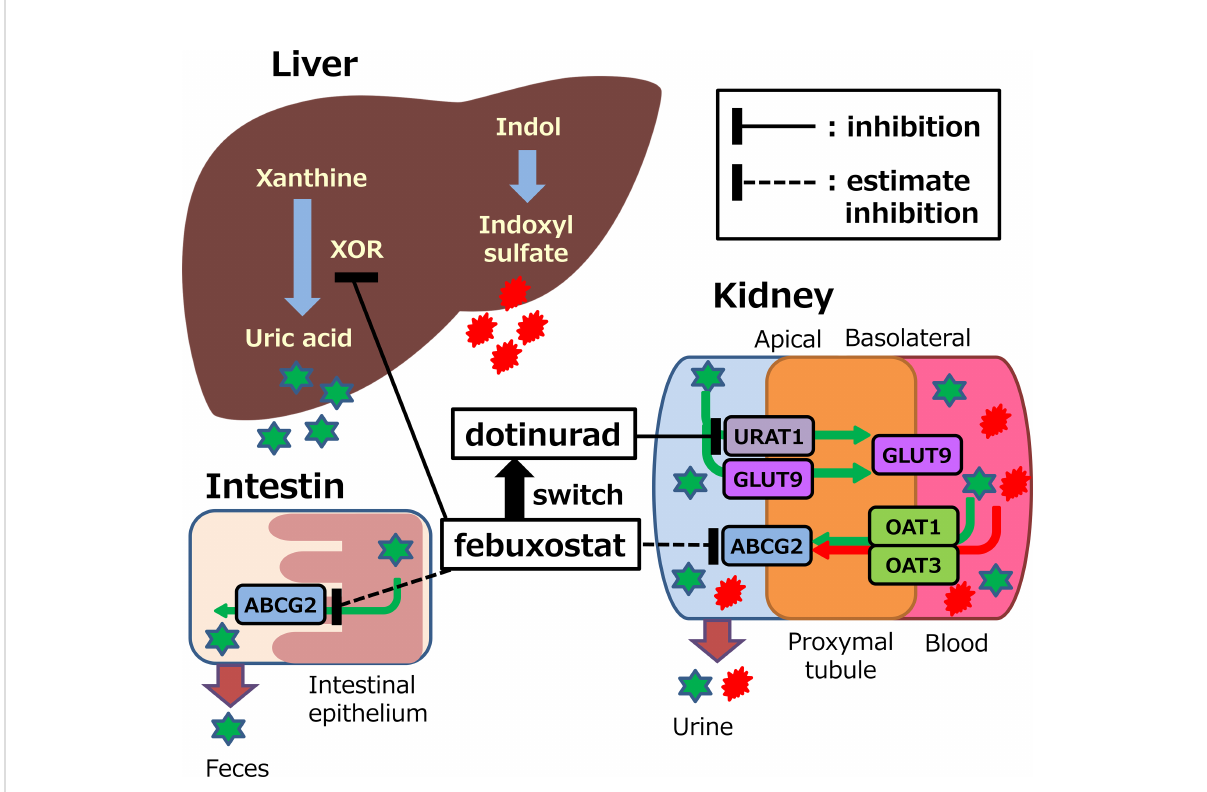
FIGURE 1 Potential mechanisms of action of febuxostat or dotinurad on synthesis and excretion of uric acid and indoxyl sulfate. XOR, xanthine oxidoreductase; URAT1, urate transporter 1; ABCG2, ATP binding cassette, subfamily G, 2; OAT, organic anion transporter; GLUT9, glucose transporter